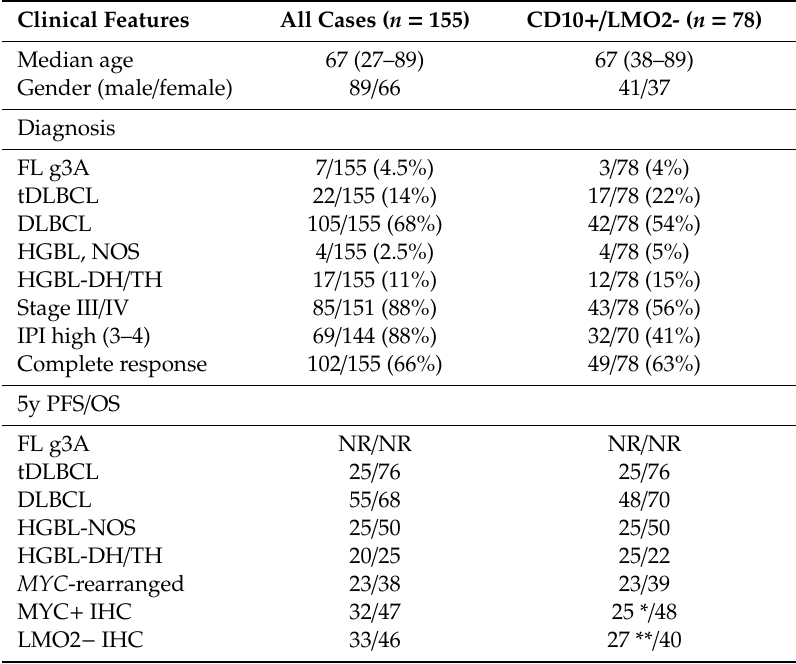
Table 3. Clinical features and survival of patients with aggressive LBCL.